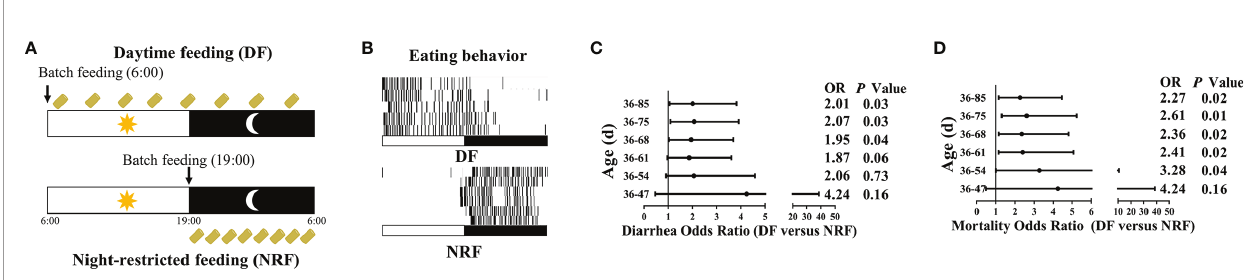
FIGURE 1 | Experimental design and morbidity of growing rabbits (n = 216). (A) Design of animal feeding regimens. DF rabbits were allowed access to food throughout the day. NRF rabbits were allowed access to food from 19:00 PM to 6:00 AM. Yellow boxes indicate food availability. (B) The diurnal rhythm of eating behavior. (C) Odds ratio of diarrhea and (D) mortality risk in growing rabbits during the experiment. DF, daytime feeding; NRF, night-restricted